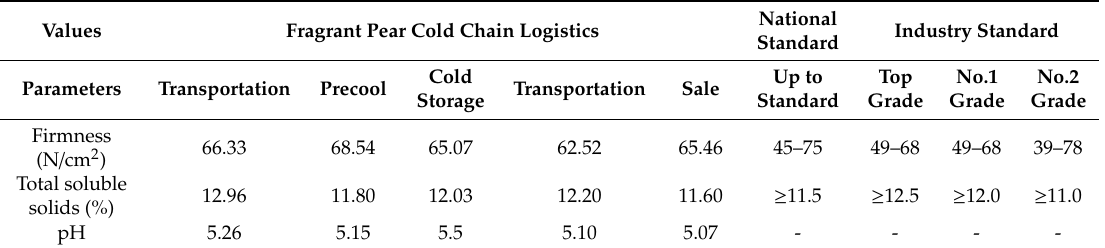
Table 3. Firmness, pH, and total soluble solids content changes of the fragrant pears.